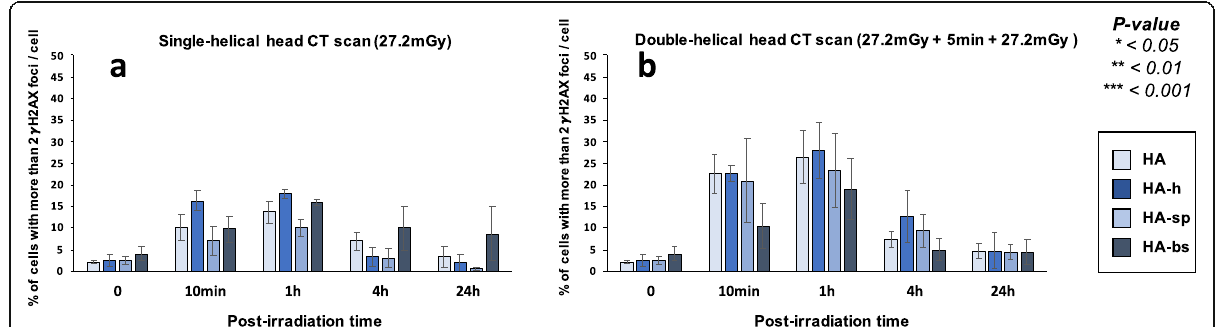
Fig. 7 Average number of cells with more than 2 γ H2AX foci in astrocytes after single- and double-helical CT scan exposure. Data are shown in Fig. 6 but expressed as the number of cells with more than 2 γ H2AX foci after single- ( a ) or double-helical ( b ) CT scan exposure. Each data represents the mean ± SEM of 3 independent experiments. CT Computed tomography, γ H2AX Phosphorylated forms of the H2AX histone variant molecular, SEM Standard error of the mean